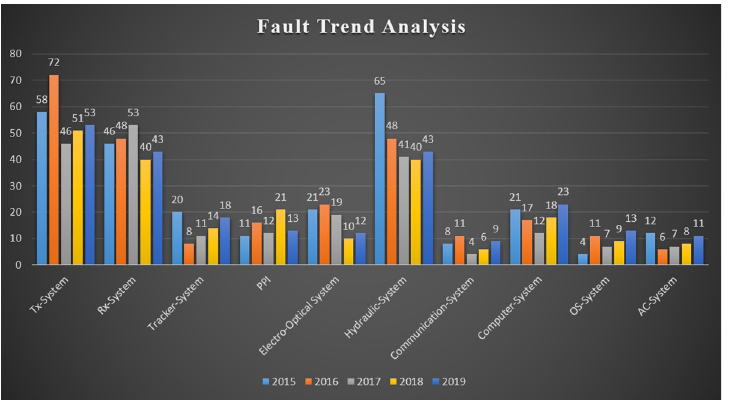
Fig 3. Fault rates in subsystems of surveillance equipment 2011–2015.